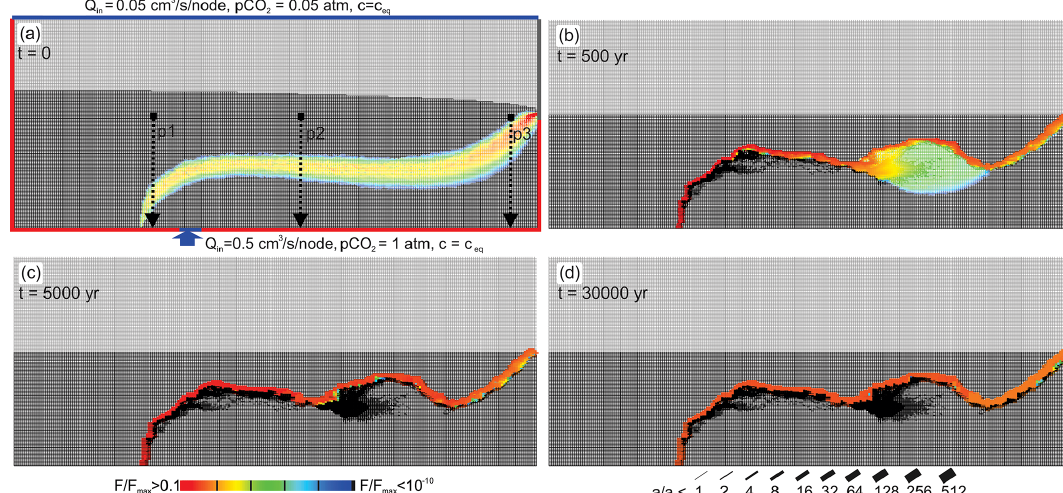
Figure 4. Temporal evolution of the standard scenario with MC exclusively. The colour code depicts rate, F , of fracture widening divided by the maximal widening F max = 10cmkyr − 1 in the net. Aperture widths, a, of fractures are shown by a bar code in units of a 0 , the initial average aperture width. After 5000 years the pattern is stable in time, and all fractures widen with rates almost constant in time. P 1 , P 2 , and P 3 are the positions of the transects of fracture aperture widths and rates of fracture widening shown in Fig. 5.